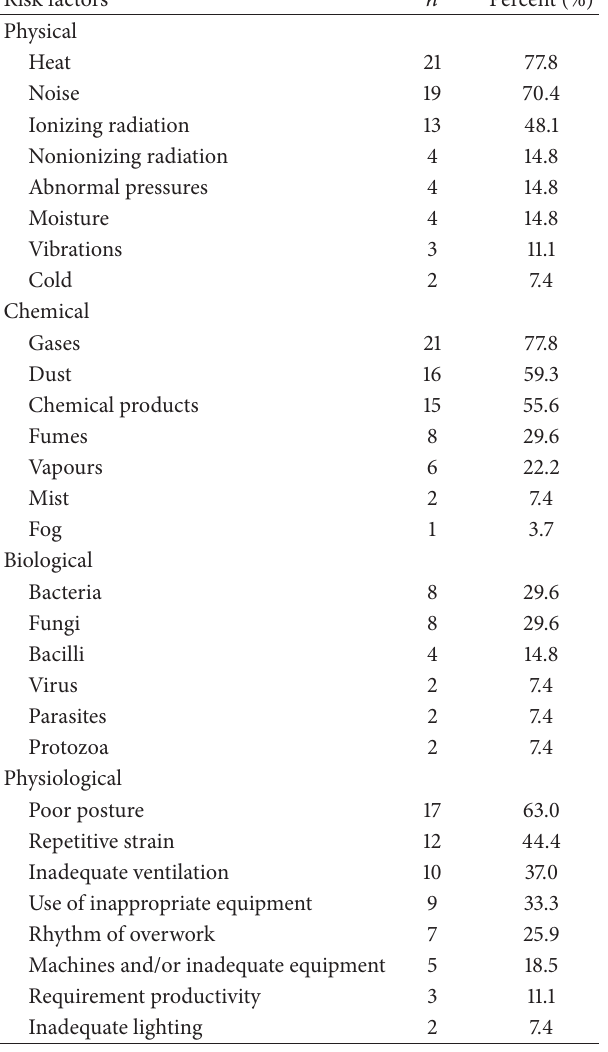
Table 2: Demographic characteristics of study subjects ( 𝑛 = 27 ). Variables